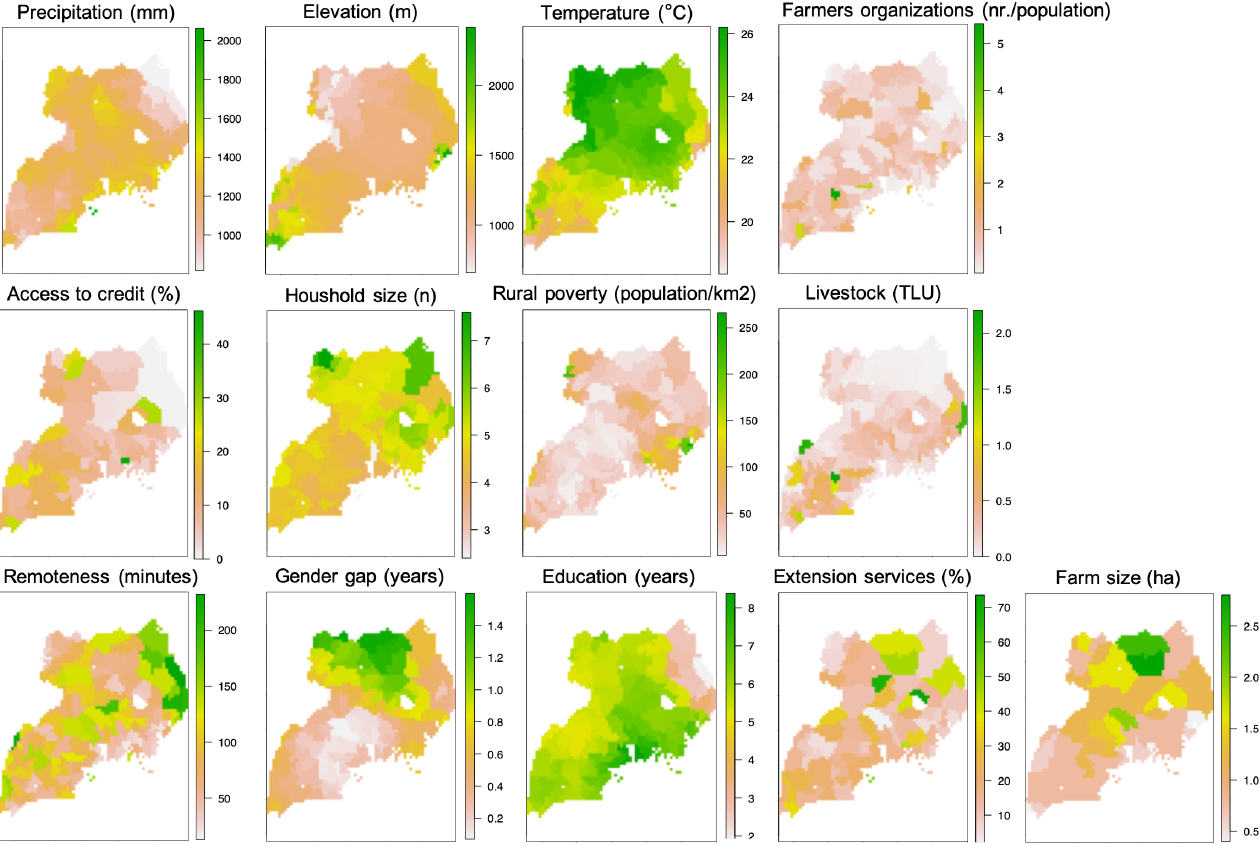
Fig. 3. Maps showing spatial attributes of the barriers to sustainable land and water management adoption in Uganda at the district level. A detailed description of these attributes is available in Table